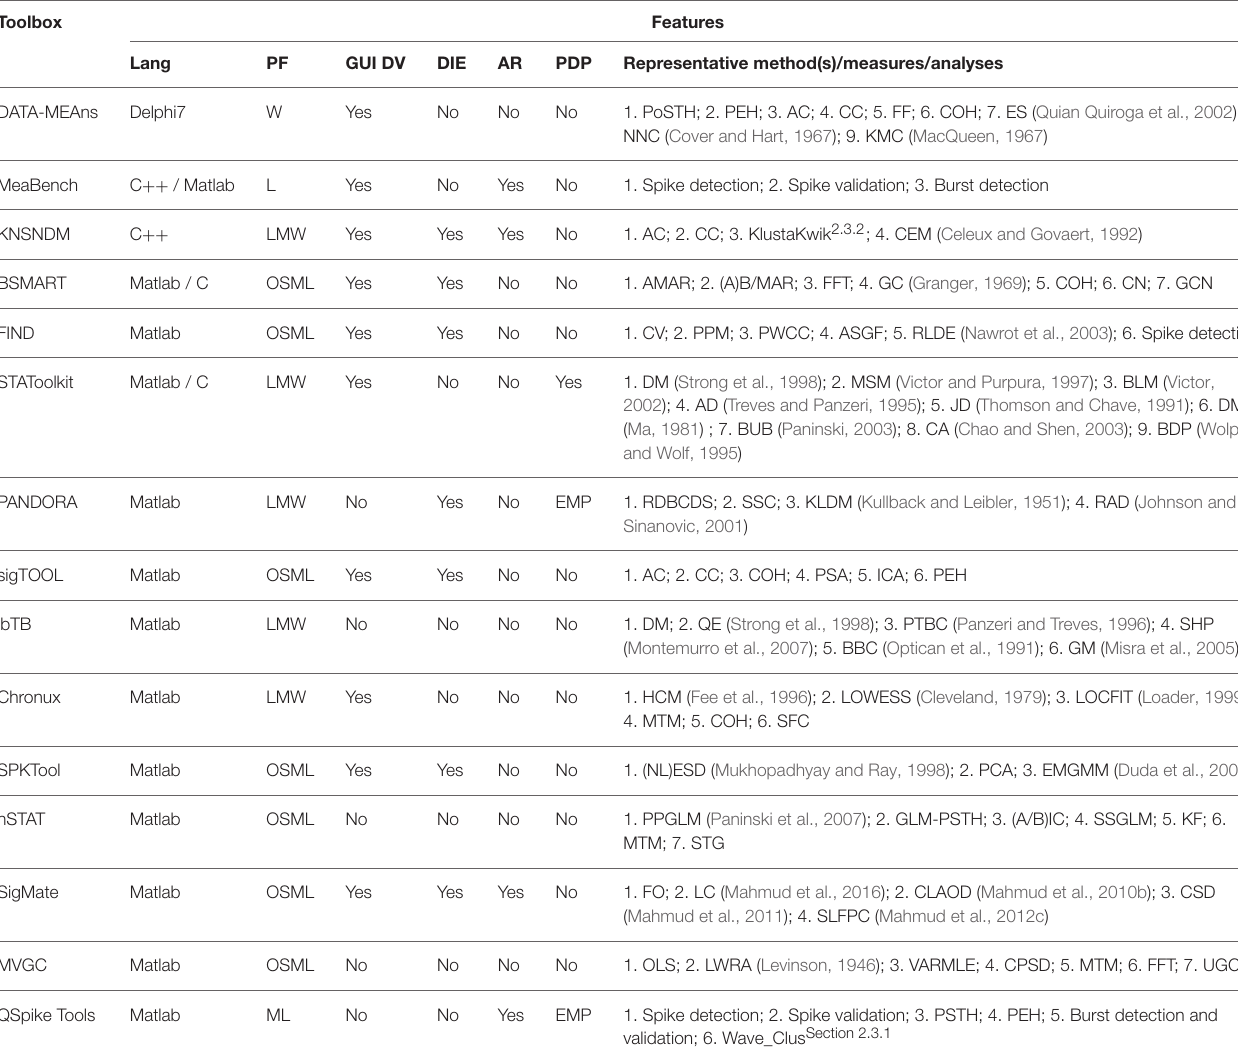
TABLE 2 | Popular spike trains and field potentials processing and analysis toolboxes with their representative features. Toolbox Features Representative